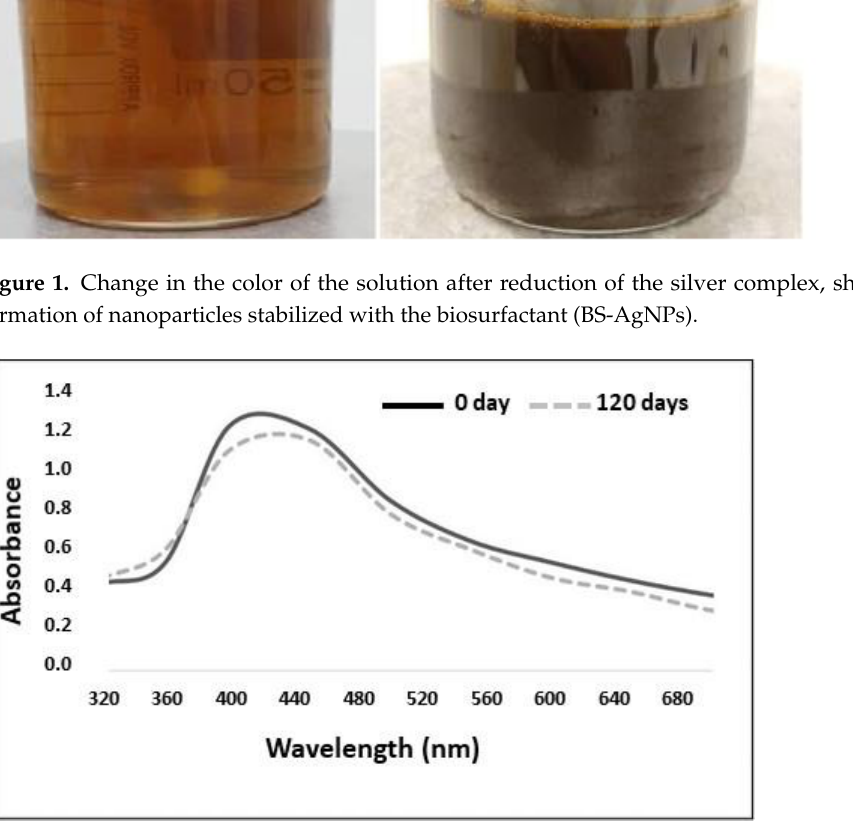
Figure 2. UV/visible spectrum of nanoparticles stabilized with the biosurfactant (BS-AgNPs) either at the start (0 days) or after 120 days of formation.